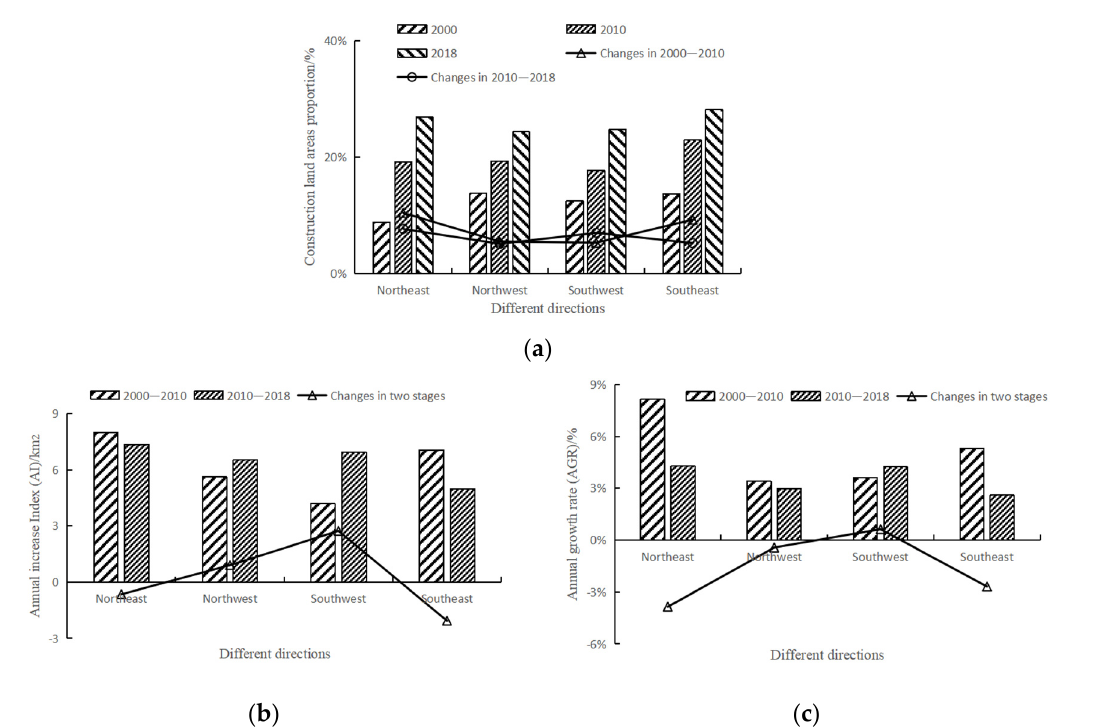
Figure 5. Characteristics of urban expansion in different directions in 2000–2018: ( a ) construction land area proportion; ( b ) annual increase index (AI); ( c ) annual growth rate (AGR).